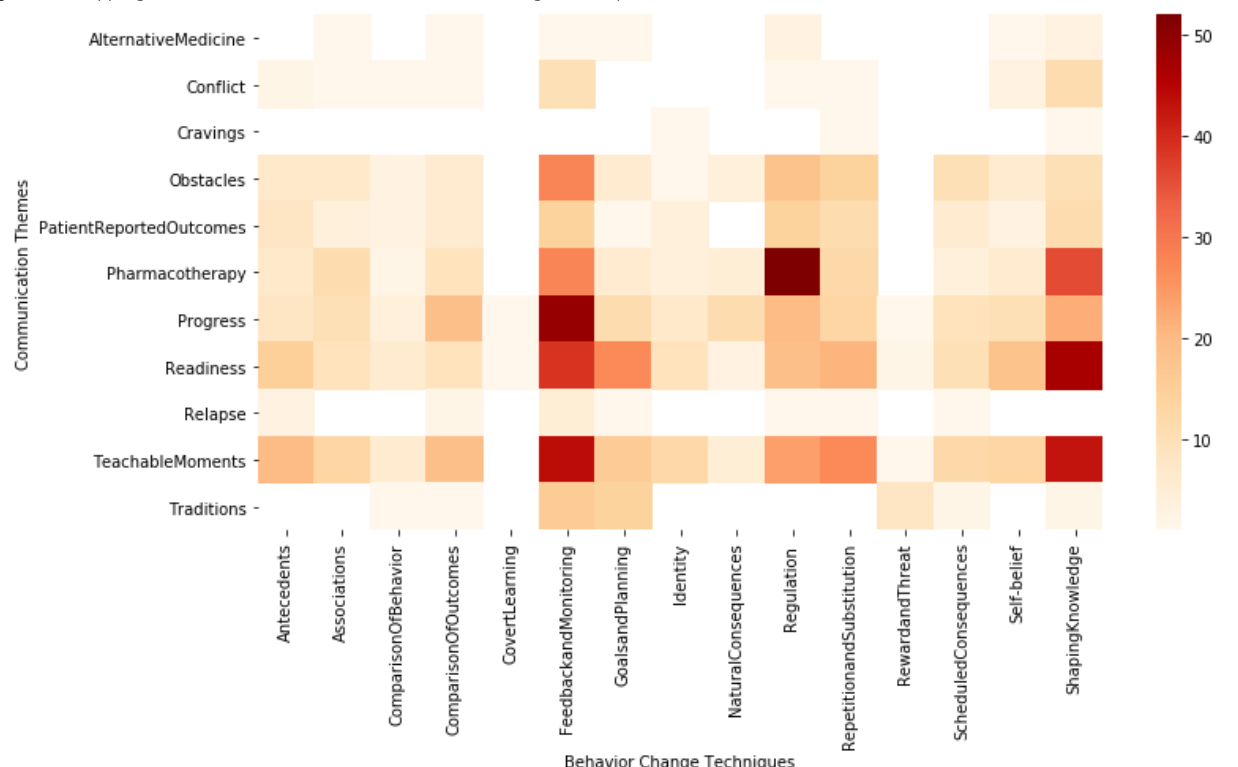
Figure 1. Mapping of communication themes and behavior change techniques.